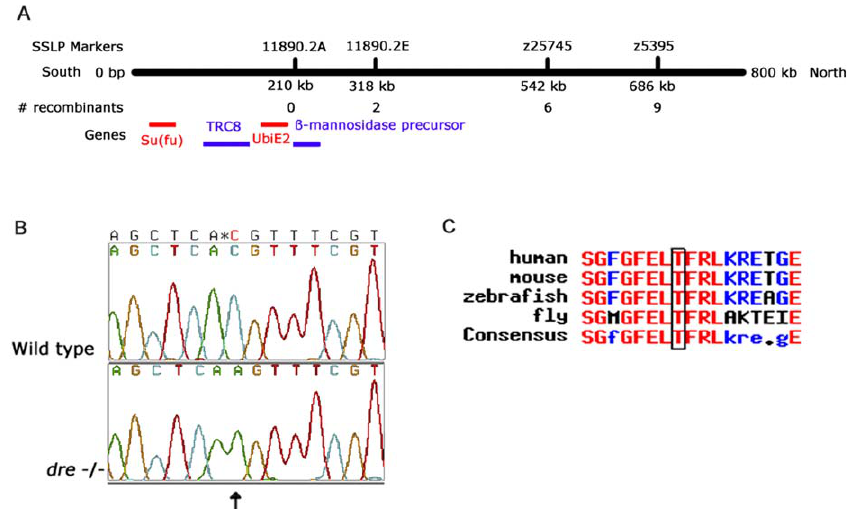
Figure 4. Positional Cloning of the dre Mutant (A) Schematic representation of assembled contig 11890 of the Zv2 genome assembly. SSLP markers z5395 and z25745 and newly identified SSLPs 11890.2A and 11890.2 were closely linked with the dre locus. Remaining recombinants of a complete panel of 765 mutant embryos are indicated. Four genes were predicted in the region of marker 11890.2A that encode Su(fu), TRC8, ubiquitin conjugating enzyme E2, and b -mannosidase precursor protein. (B) The dre mutation is a C to an A substitution, changing a threonine to a lysine. (C) Multiple alignment of Su(fu) homologs revealed that the induced mutation changes an amino acid in a highly conserved region of Su(fu). DOI: